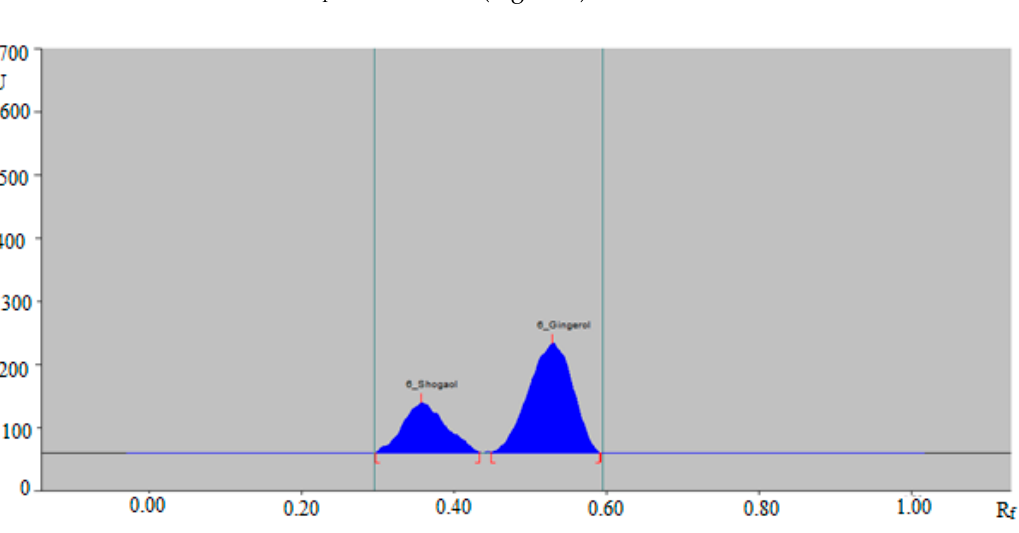
Figure 2. High-performance thin layer chromatography (HPTLC)-densitogram of standard 6-SHO and 6-GIN.